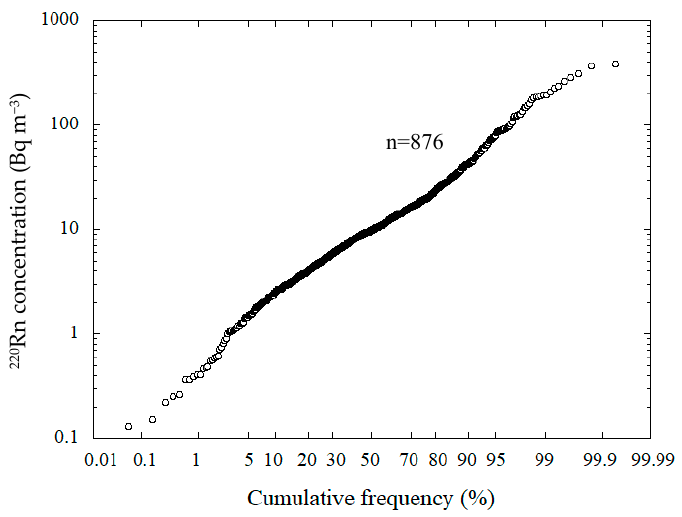
Figure 2. Cumulative frequency distribution for indoor 220 Rn concentrations. This figure has been prepared using the mean annual 220 Rn concentrations in excess of zero Bq m − 3 . Table 1. 220 Rn concentrations measured in the different seasons. Number Measurement Period